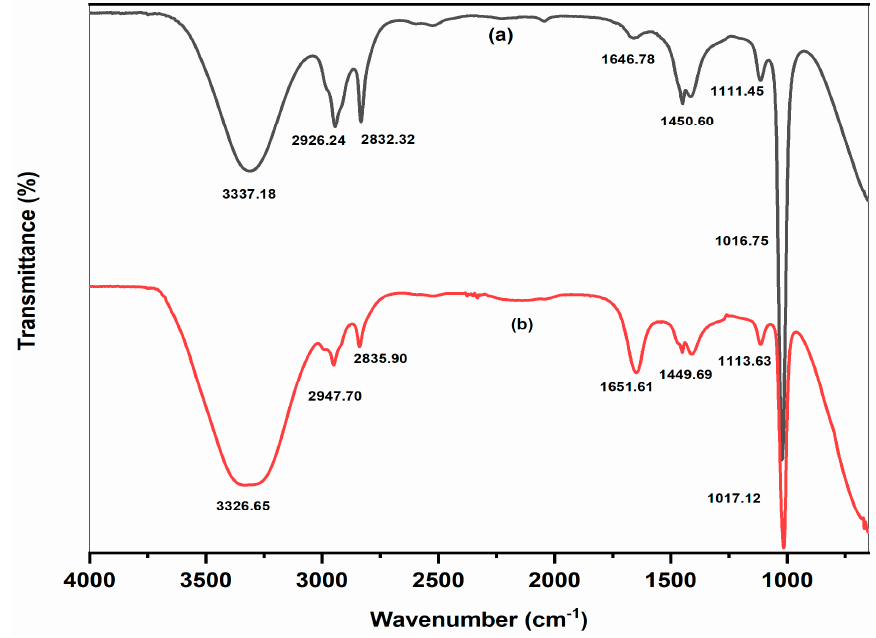
Figure 6. Comparative FTIR spectra of Trigonella foenum-graecum L. leaves extract ( a ) and biosynthesized AgNPs ( b ). Table 2. FTIR analysis of Trigonella foenum-graecum L. leaves extract and biosynthesized AgNPs.